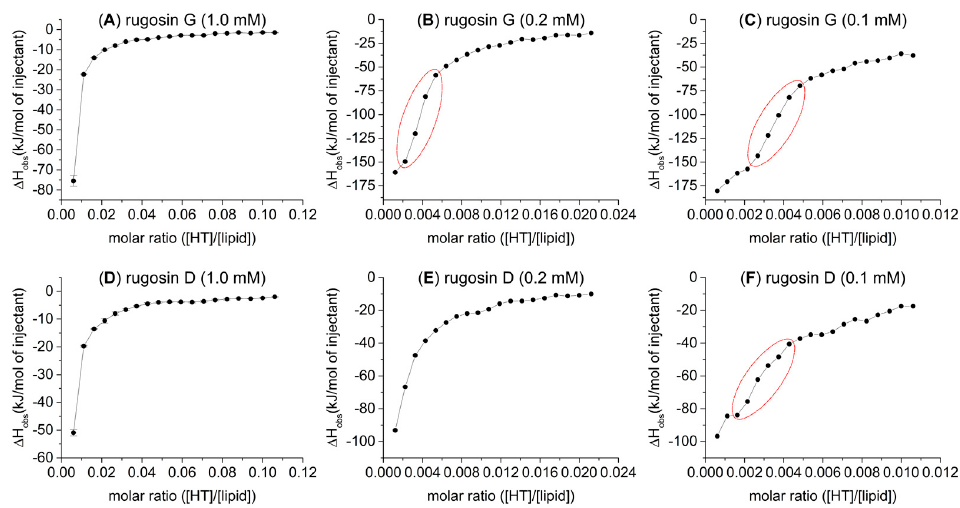
Figure 5. Observed heat rates of injection of 1.0 mM ( A , D ), 0.2 mM ( B , E ), and 0.1 mM ( C , F ) rugosin G ( 24 ) and rugosin D ( 21 ) as functions of the molar ratio ([HT]/[lipid]) in the sample cell. Heat rates presented as kJ/mol. Increased sigmoidal curve regions highlighted with red in ( B ), ( C ), and ( F ).